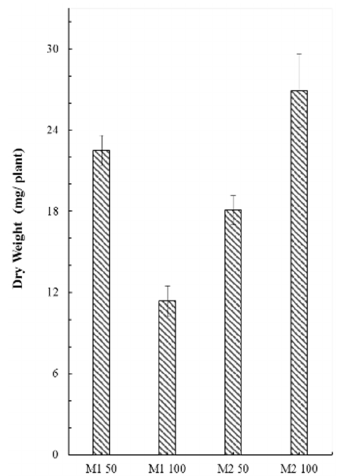
Figure 1. Graph of the substrate mixture (M1 and M2)—fertilizer concentration (50 and 100) effecton dry weight of coriander plants.